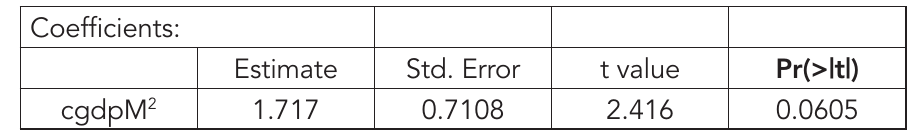
Table 8: Regression results for estimating noise cost